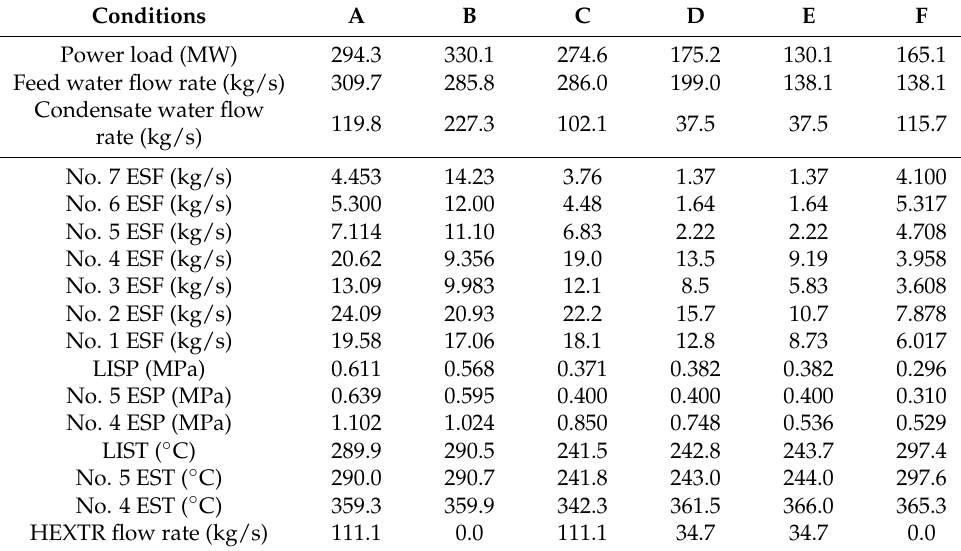
Table 1. Design and operation parameters under typical operation